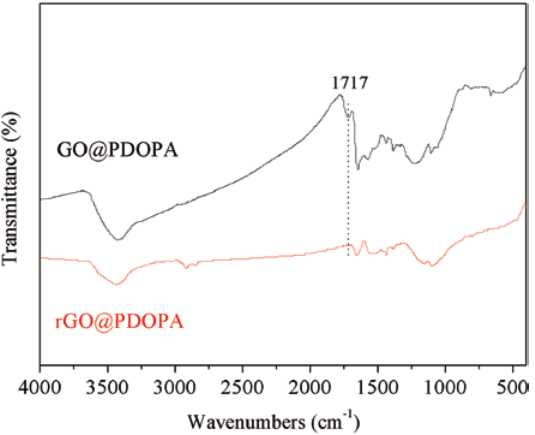
Figure 1: FT-IR spectra of GO@PDOPA and rGO@PDOPA.